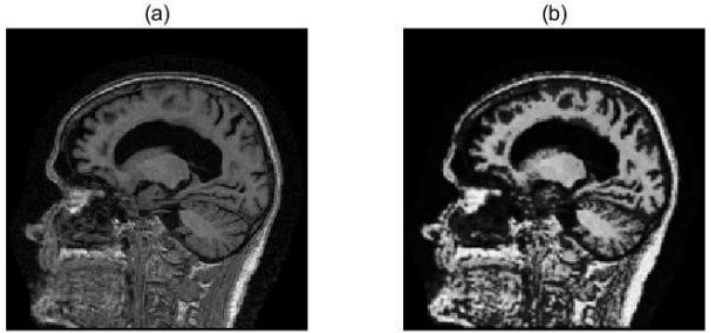
Figure 10. ( a ) Previous image. ( b ) After contrast